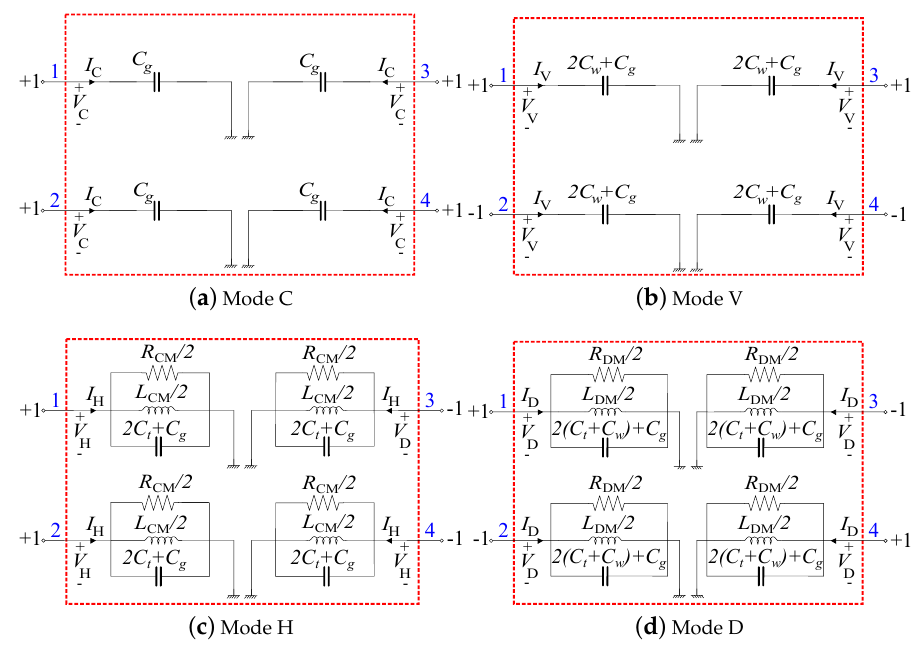
Figure 2. Equivalent circuits of the modes obtained for the high-frequency circuit of the CMC in Figure 1b. Normalized voltages at the four terminals of the CMC are indicated for each